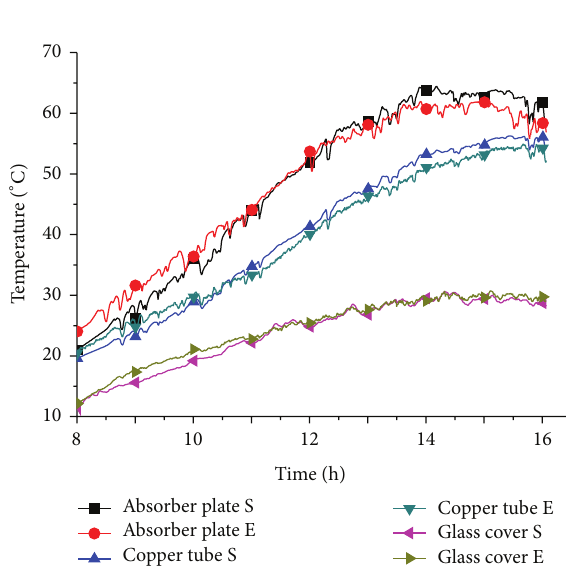
Figure 8: Variation of the water temperatures in the tank with time (E: experimental results; S: numerical results).